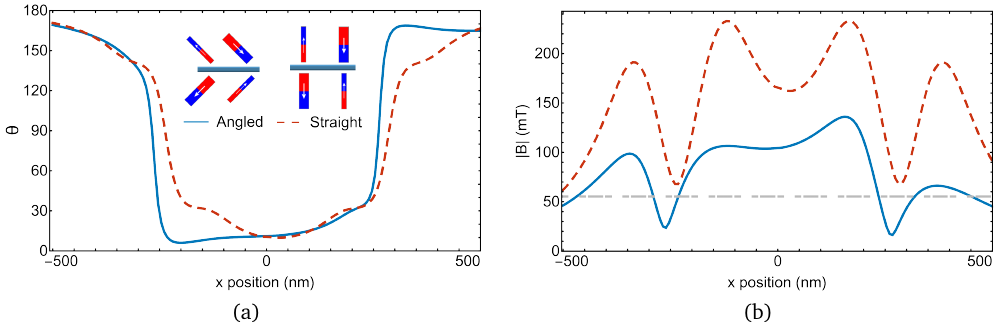
Figure 8: This compares the a rotated and un-rotated Dragonfly configuration. The solid line is the rotated set-up and the dashed line is the straight set-up. Rotating the magnets makes them easier to magnetize through hysteresis. This figure is for a 1000 nm nanowire